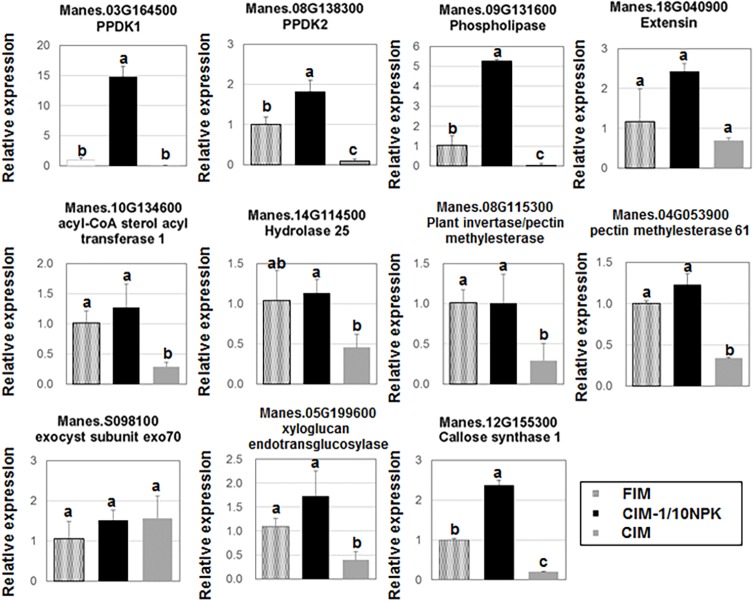
Comparison on genes associated with metabolic pathway and cellular component in FEC cultivated on three kinds of media by qRT-PCR analysis.The y-axis is relative expression level normalized against the expression level in FEC on FIM. CIM-Ρ NPK was composed of CIM in which nitrogen, phosphate, and potassium was reduced. FIM was composed of CIM in which nitrogen, phosphate, and potassium was reduced and a10 mg/L vitamin B1 was added. Means and standard deviation were represented as two independent measurements with 3 biological repeats. Values labeled with different letters (a, b and c) at all conditions are significantly different by Scheff’s multiple comparison tests at P<0.05.